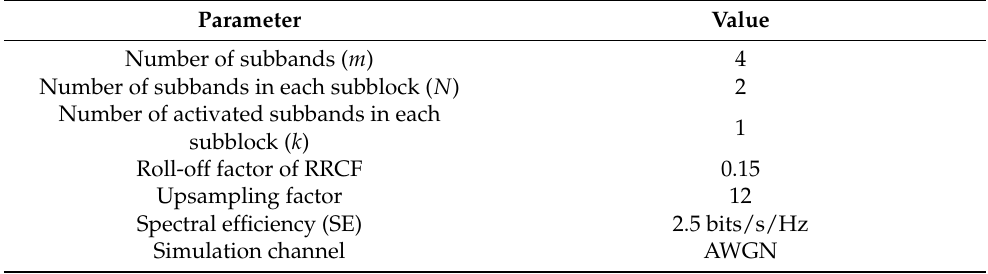
Table 2. Simulation